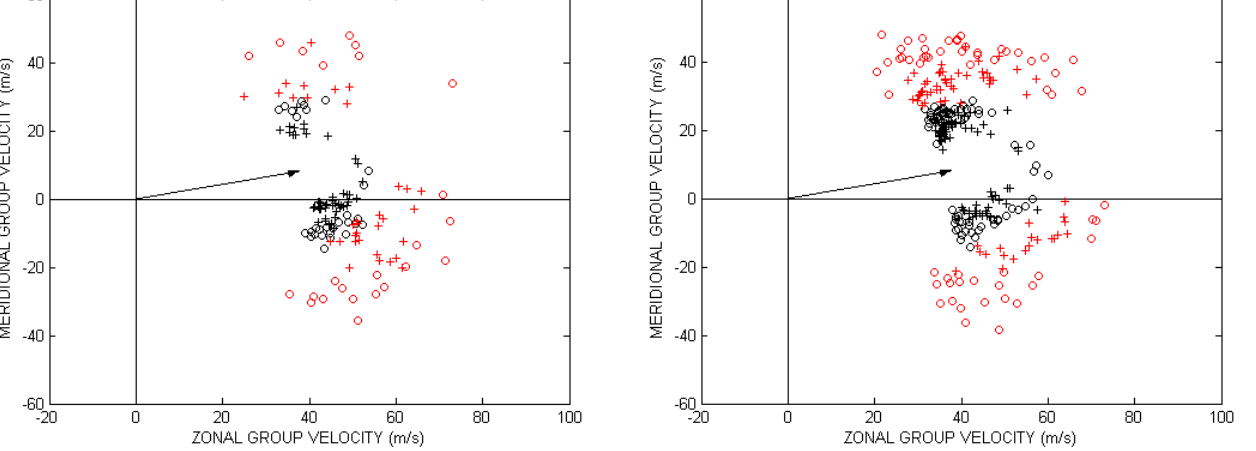
Fig. 16. Scattering plots of the virtual horizontal group velocities Fig.16 Scattering plots of the virtual horizontal group velocities of the upward gravity of the upward gravity wave packets of the winter data. Wave pack- wave packets of the winter data. Wave packets obtained by windows T2Z4 ets obtained by windows T2Z4 were denoted by cross; wave pack- were denoted by ‘cross’ ; wave packets obtained by windows T2Z5 were ets obtained by windows T2Z5 were denoted by open circle. Red colour symbols represent the model with VB-period of 5min, and denoted by ‘open circle’. Red color represents the model with VB-period of 5 black colour symbols represent the model of VB-period of min, and black color represents the model of VB-period of 10 min.